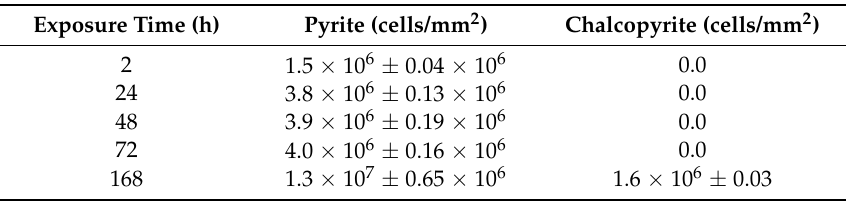
Table 2. Approximate cell concentration on mineral